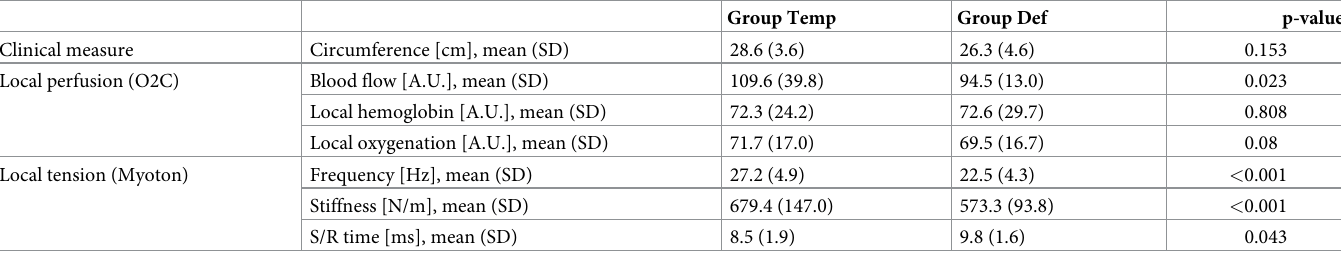
Group Temp p-value